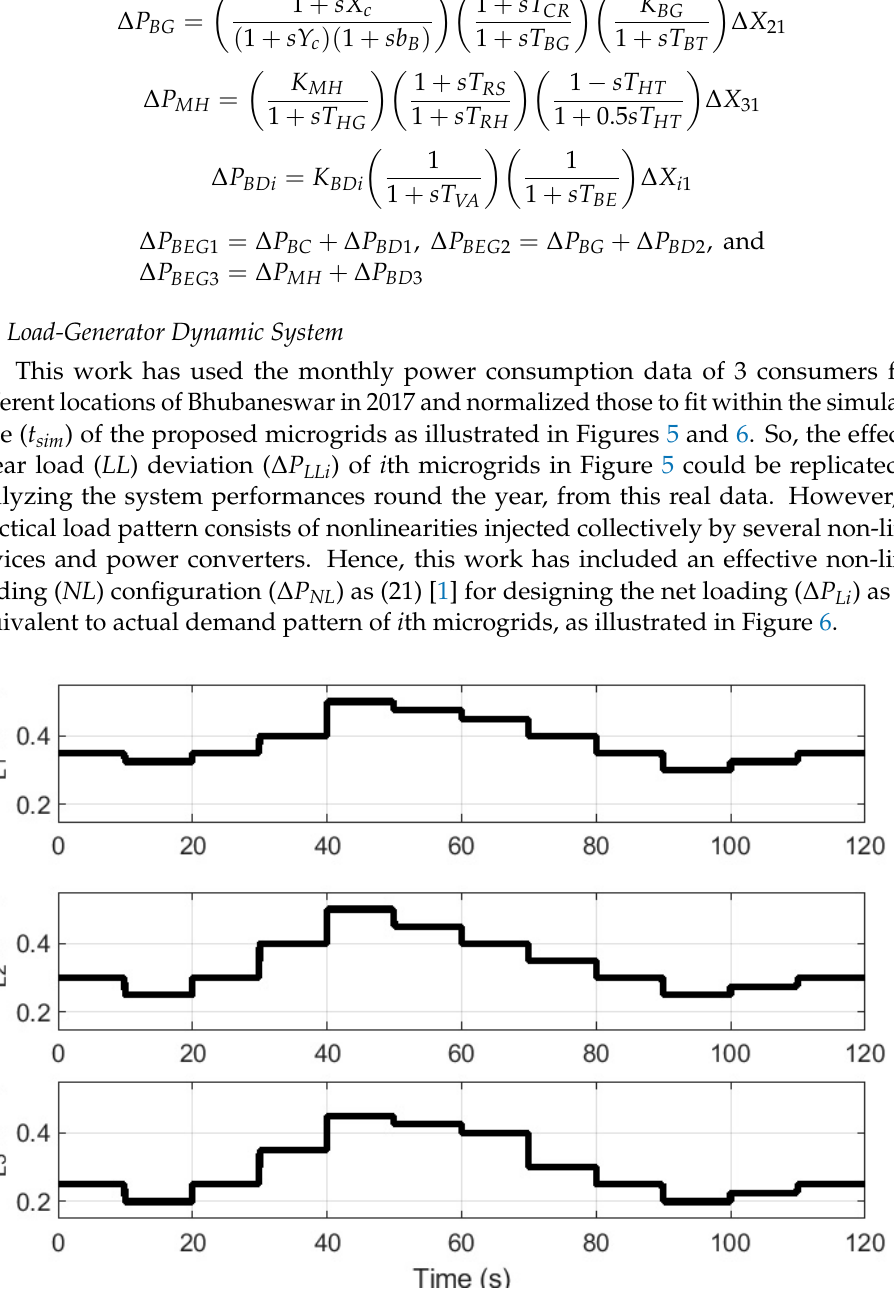
Figure 6. Loading pattern of 3 microgrids considering both LL and NL. (